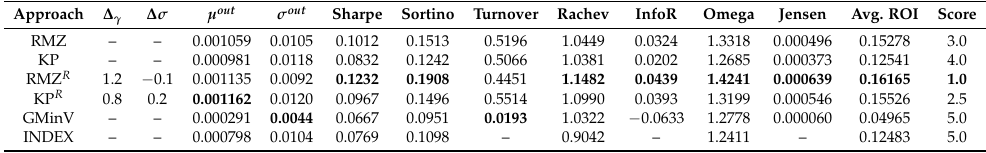
Table 20. Summary of results for